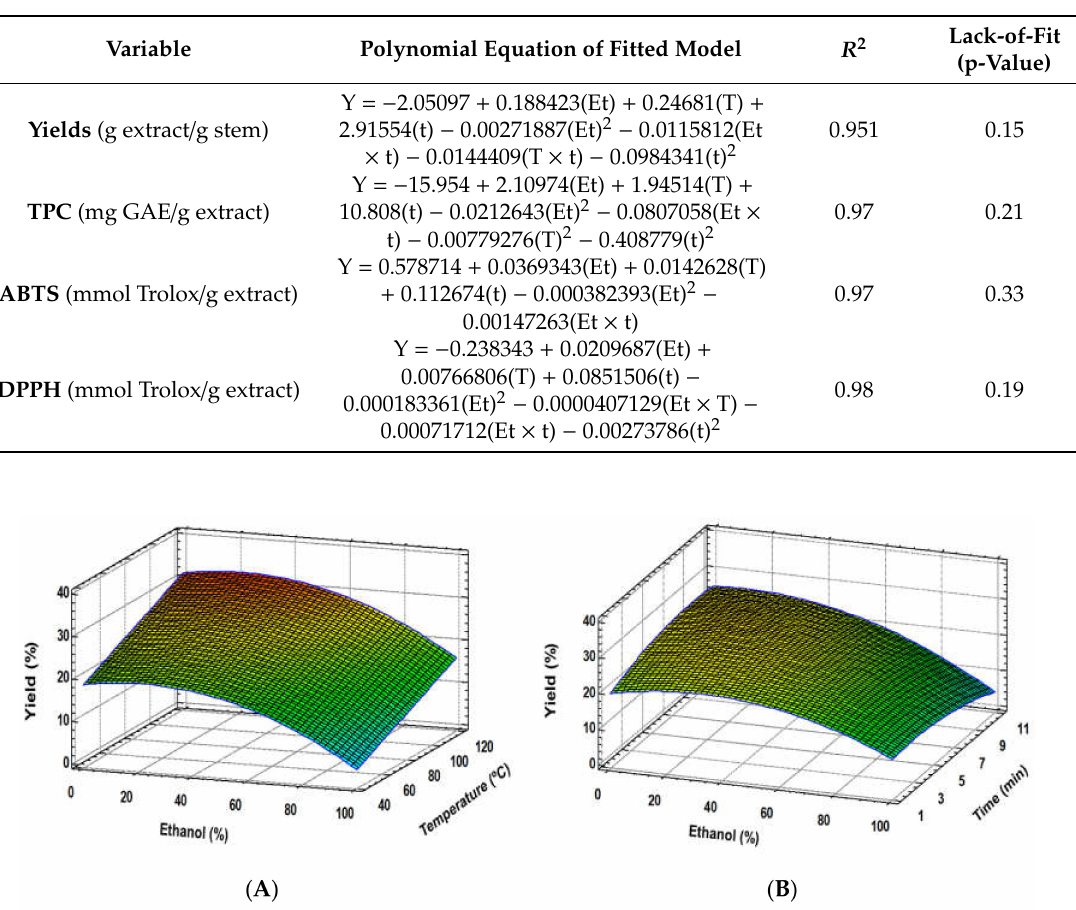
Figure 1. Response surface plots of the extraction yield as a ff ected by independent factors; ethanol (%) vs . temperature ( A ), ethanol (%) vs . time ( B